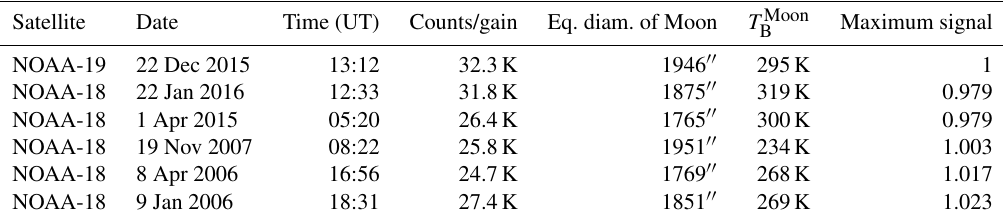
Table 4. Moon intrusion events observed with MHS where the image of the Moon crossed the center of the field of view. The size of the various corrections applied in calculating the maximum signal in each light curve is given. This signal is normalized so that the value measured with NOAA-19 is